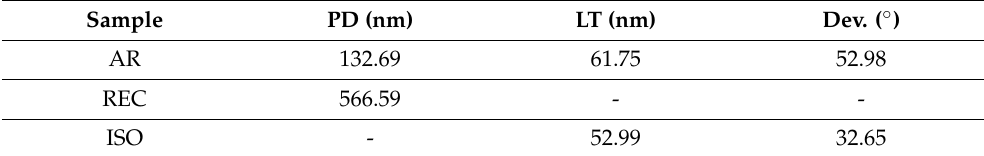
Table 4. Quantitative analysis of heat treated microstructures compared to AR sample: average par- ticle diameter (PD), average lamellae thickness (LT) and preferred deviation in relation to RD (Dev.). Sample